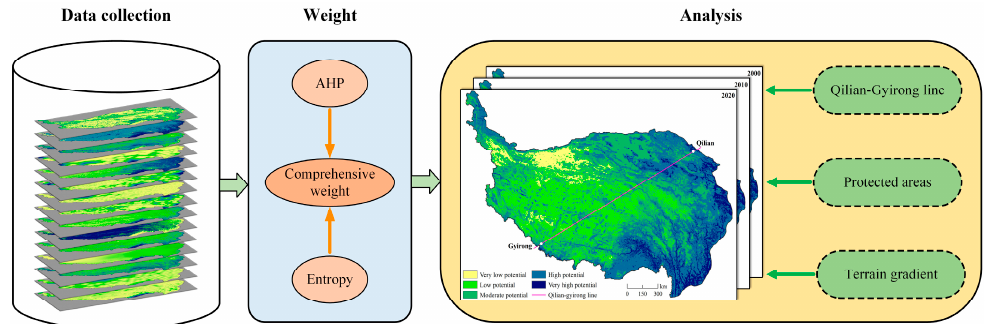
Figure 2. Research framework of this study.